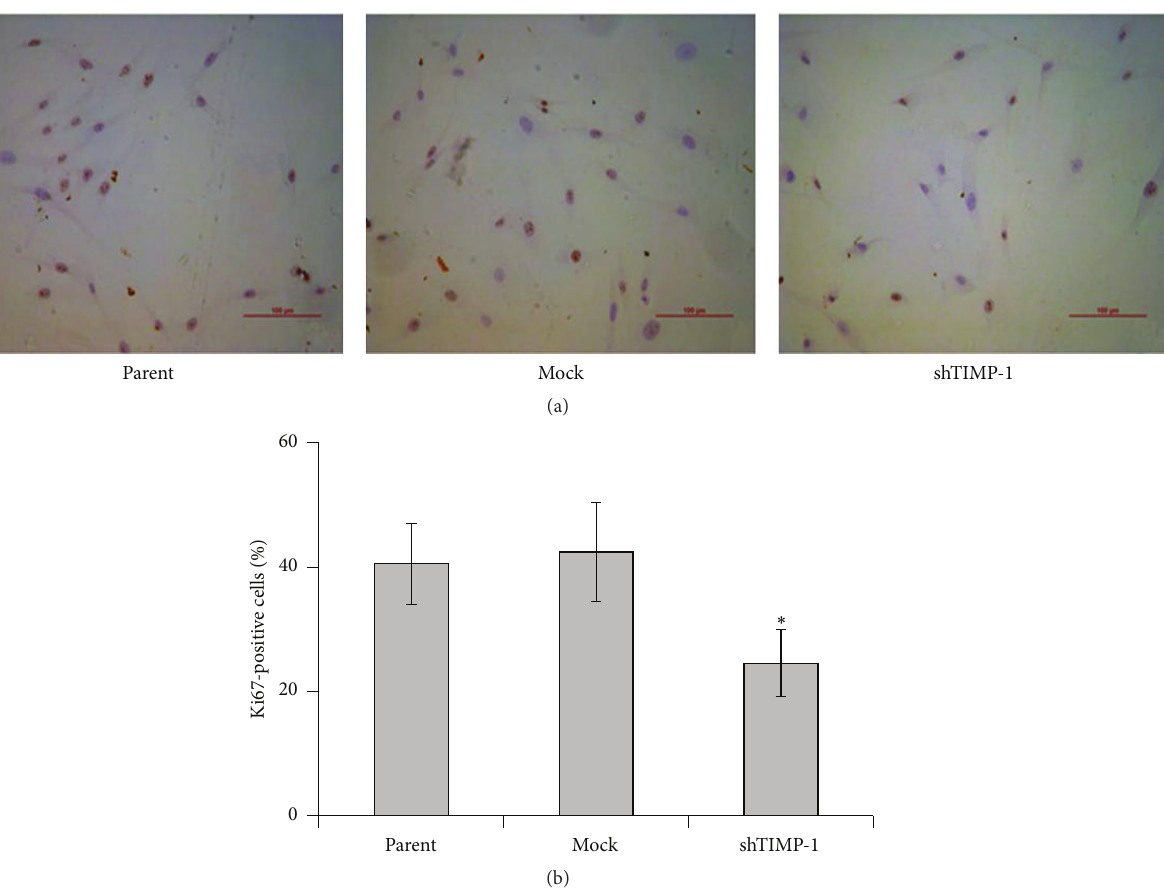
Figure 4: Immunocytochemical staining of Ki67. Ki67 staining was performed to evaluate cell proliferation after TIMP-1 knockdown in the ADSCs. (a) Representative images of Ki67 staining in the parental ADSCs, mock-shRNA ADSCs, and shTIMP-1 ADSCs. (b) Percentage of Ki67 positive cells was quantified in four random areas as described in Section 2. The data are denoted as mean ± SD ( 𝑛 = 4 ). ∗ 𝑃 < 0.05 versus mock-shRNA groups. Scale bar: 100 𝜇